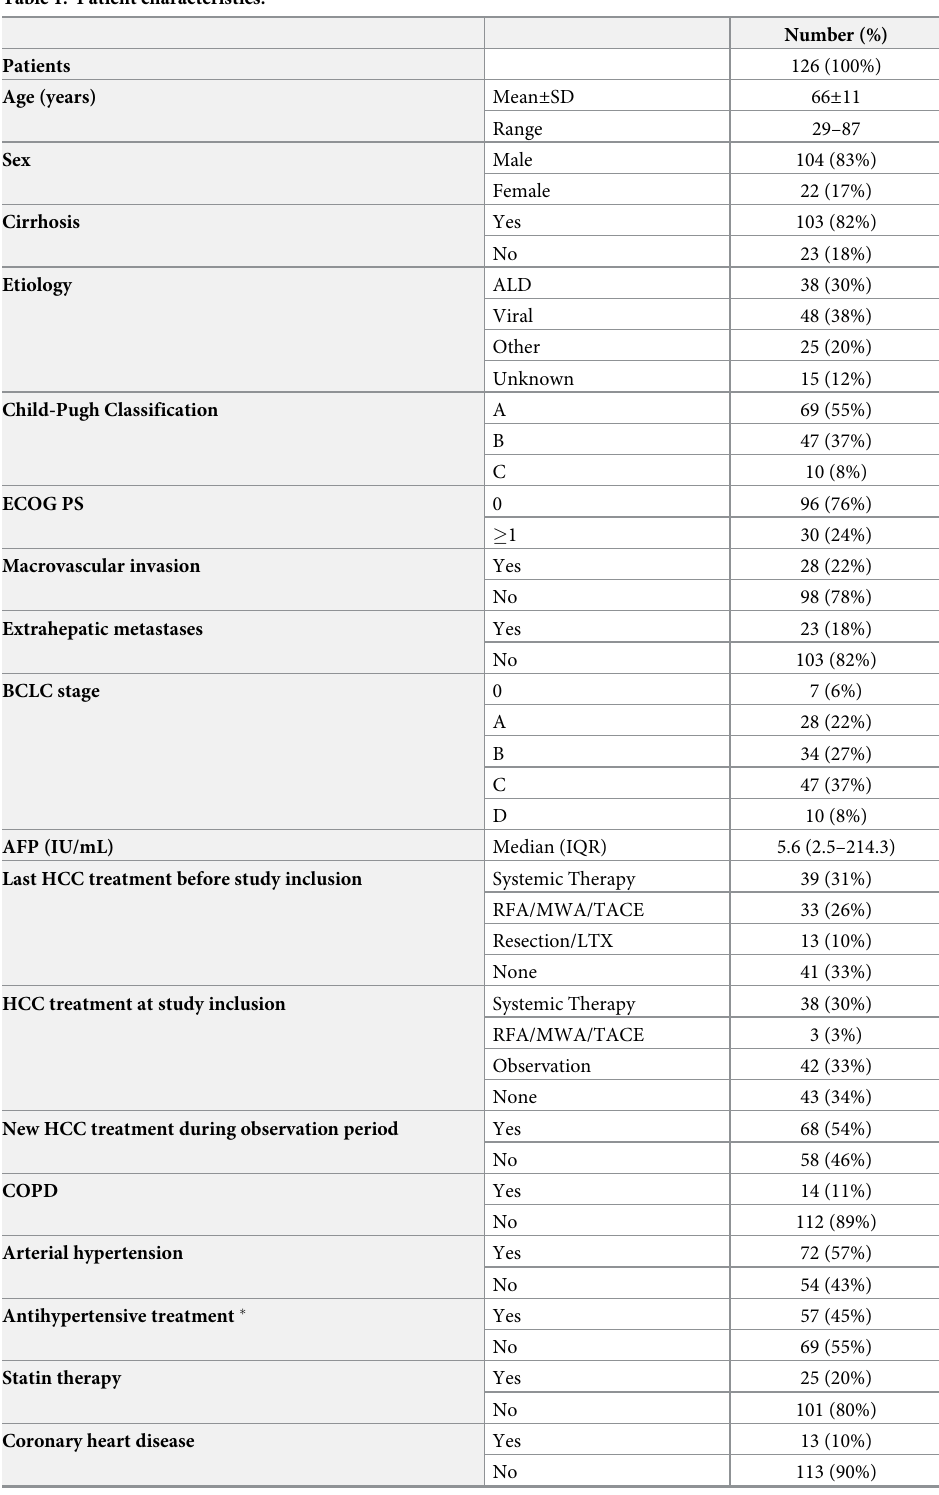
Table 1. Patient